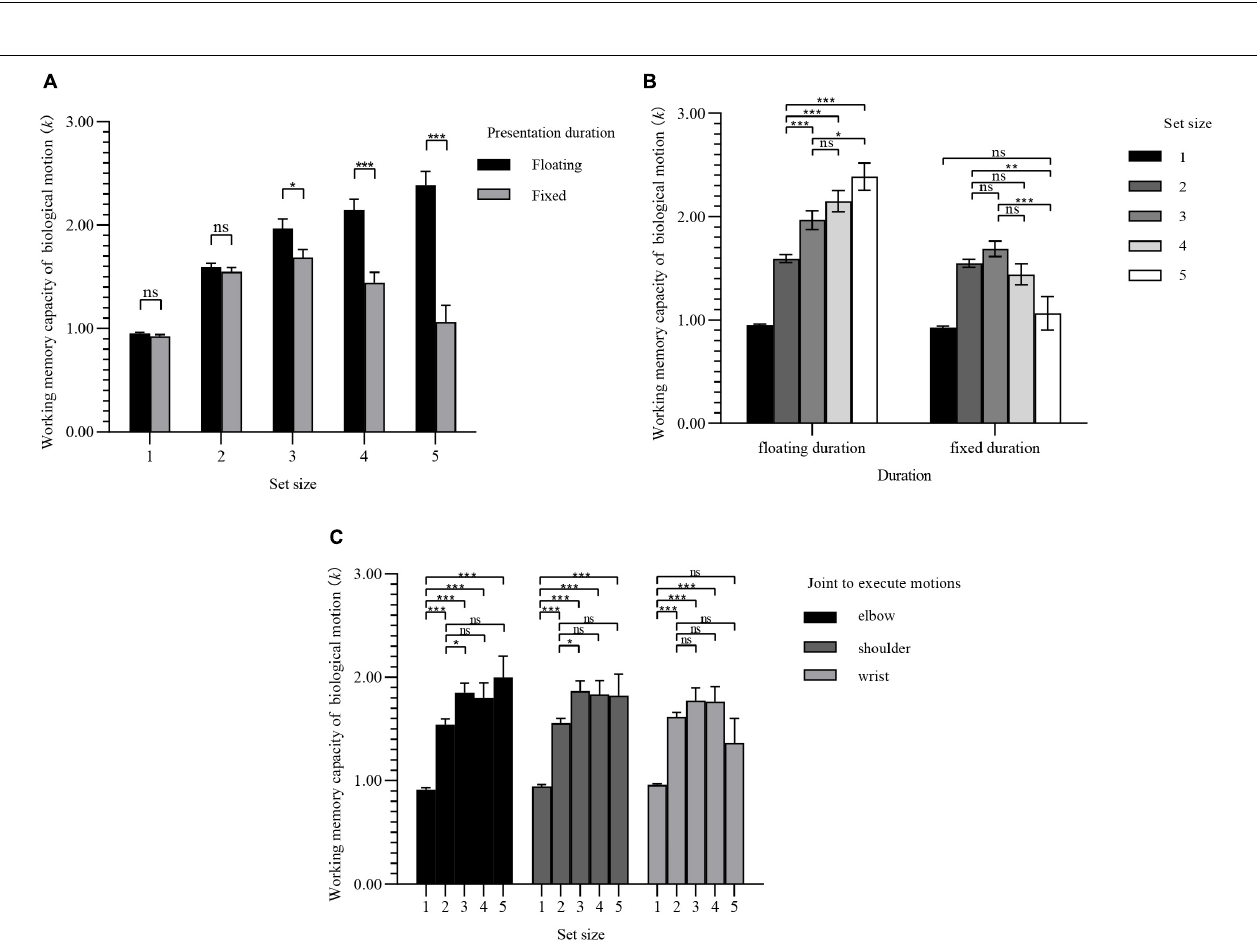
FIGURE 3 | WMC of BM for each group of experiment 1. Values are reported as mean ± standard error.